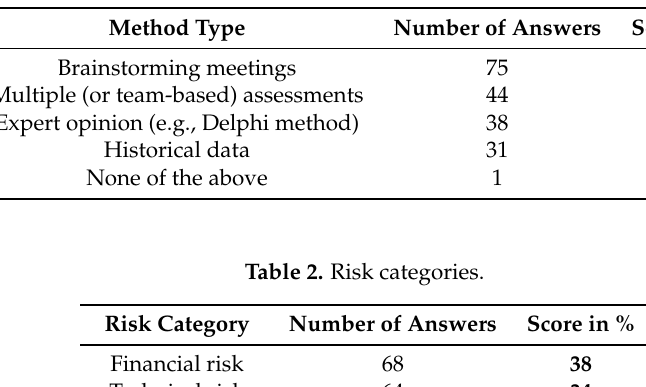
Table 1. Methods of risk identification .